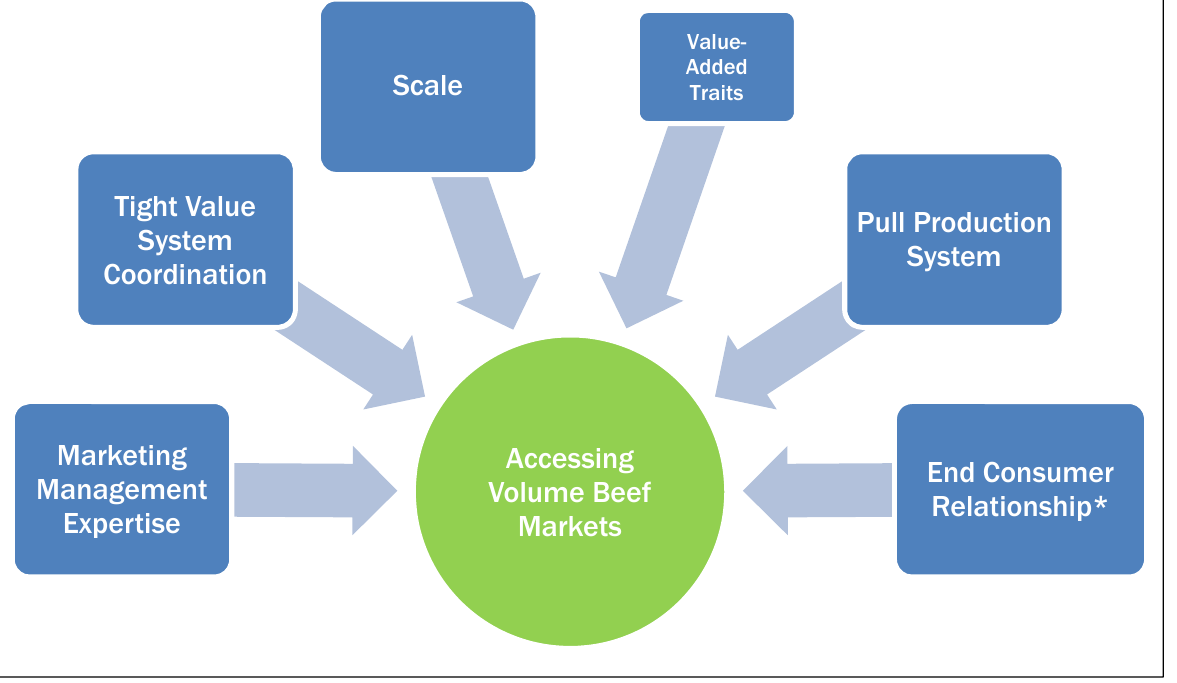
Figure 3. Country Natural Beef Model